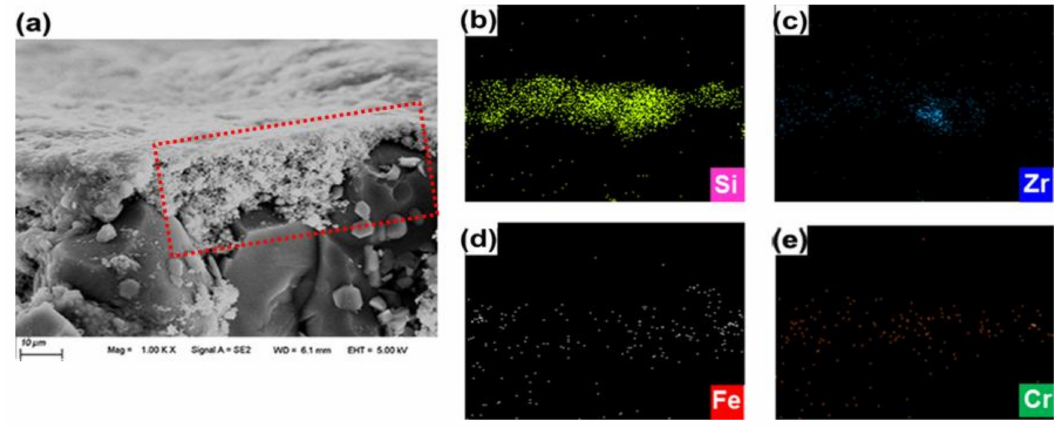
Figure 7. SEM ( a ) and EDX ( b – e ) images of cross-section of the BTESE-200 membrane after a continuous PV operation of 50